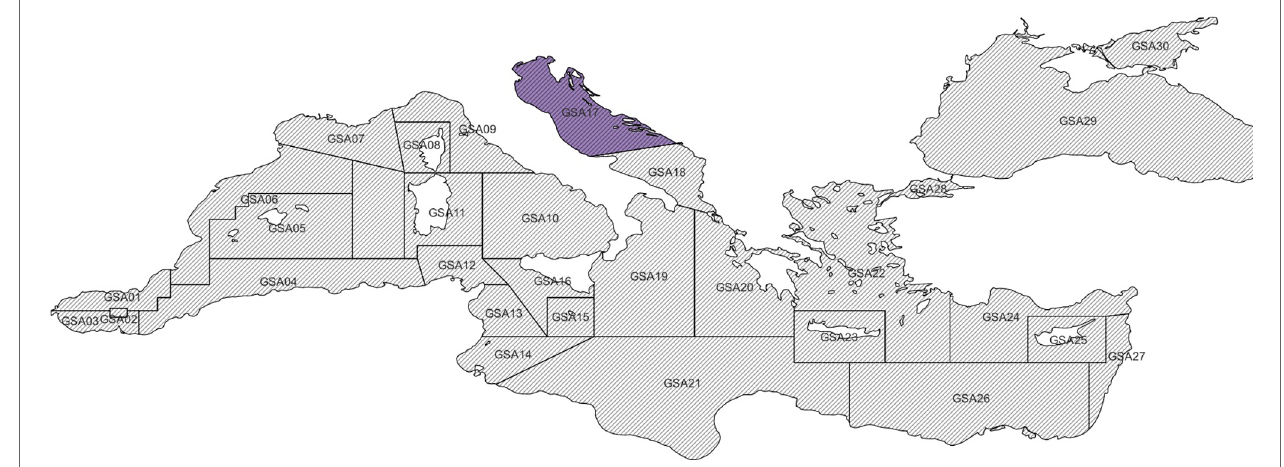
FIGURE 1 | Distribution of Mediterranean geographical subareas (GSAs) of the General Fisheries Commission for the Mediterranean, with the highlight of the GSA- 17 addressed by our